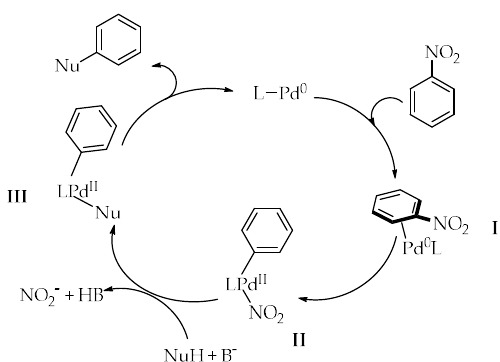
Figure 1. General plausible catalytic cycle for Pd-catalyzed Nu–C bond formation using nitroarenes. Catalysts 2019 , 9 , x FOR PEER REVIEW 3 of 8